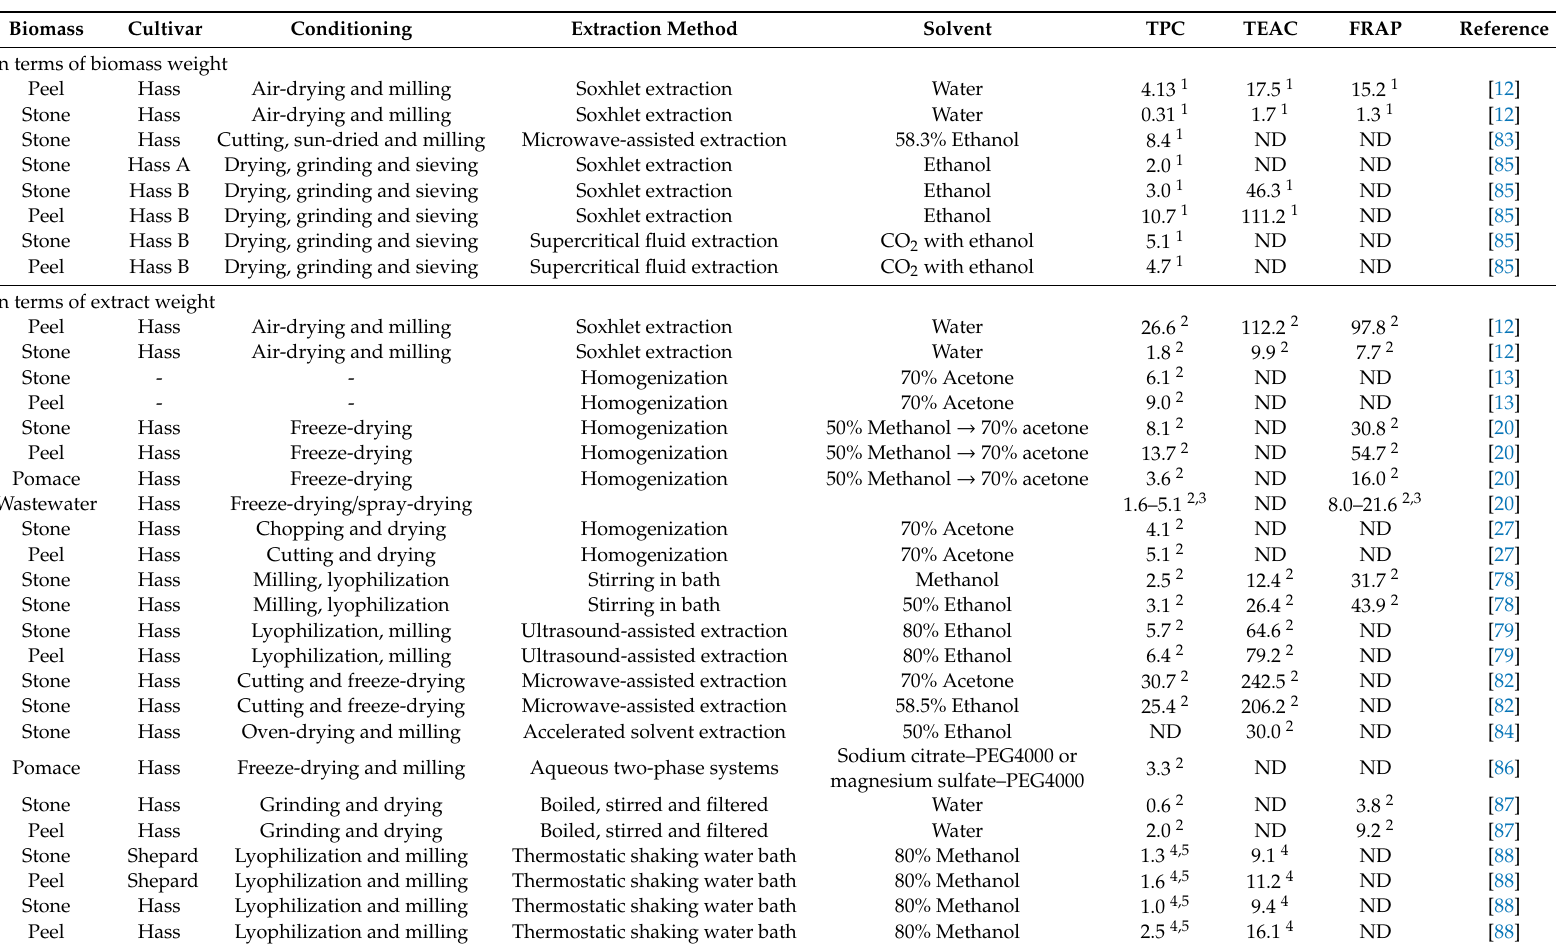
Table 5. Extraction methods applied to recover the phenolic compounds from avocado waste, total phenolic content (TPC) (g gallic acid equivalents / 100 g), and antioxidant activity, determined by the trolox equivalent antioxidant capacity (TEAC) and ferric reducing antioxidant power (FRAP) (mmol TE / 100